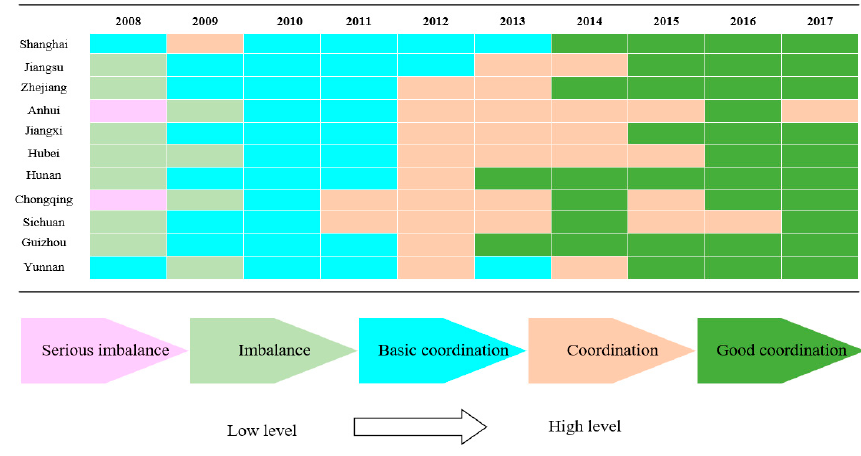
Figure 7. Trends in the coordination state in the 11 investigated regions from 2008 to 2017.